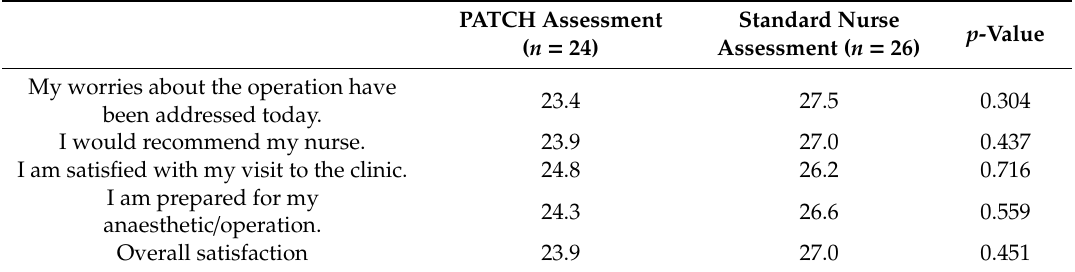
Table 3. Median satisfaction scores in PATCH and standard nurse assessment